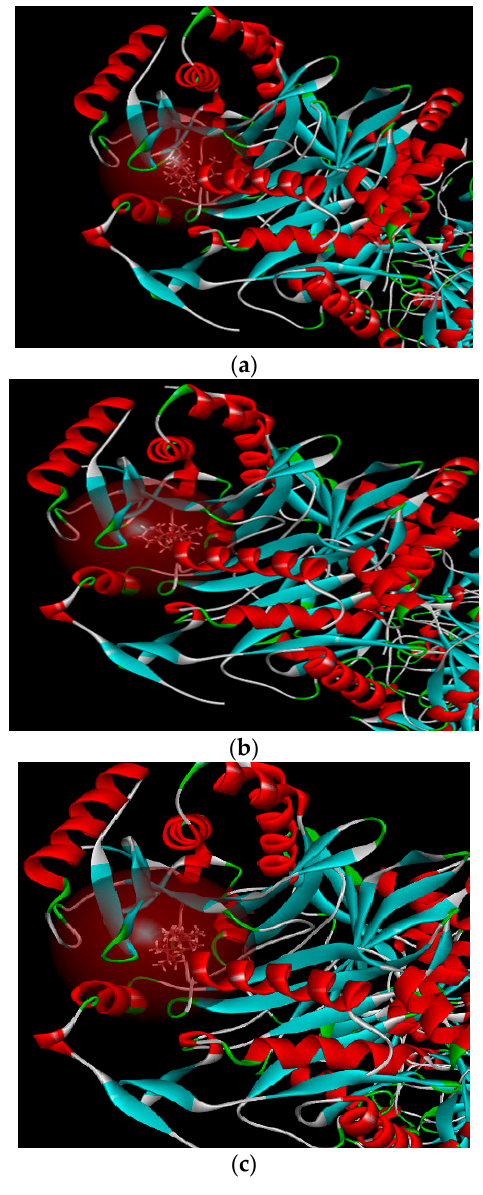
Figure 12. 2D docking dimensions of ligand–receptor interactions with fusidic acid as a control. ( a ) 2D interaction models of fusidic acid and receptor protein 1Q23. ( b ) 2D interaction models of compound 1 and receptor protein 1Q23. ( c ) 2D interaction models of compound 2 and receptor protein 1Q23.